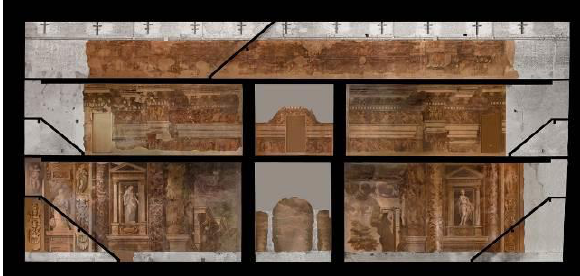
Figure 3 . Orthophoto of the fresco placed on the back wall of the